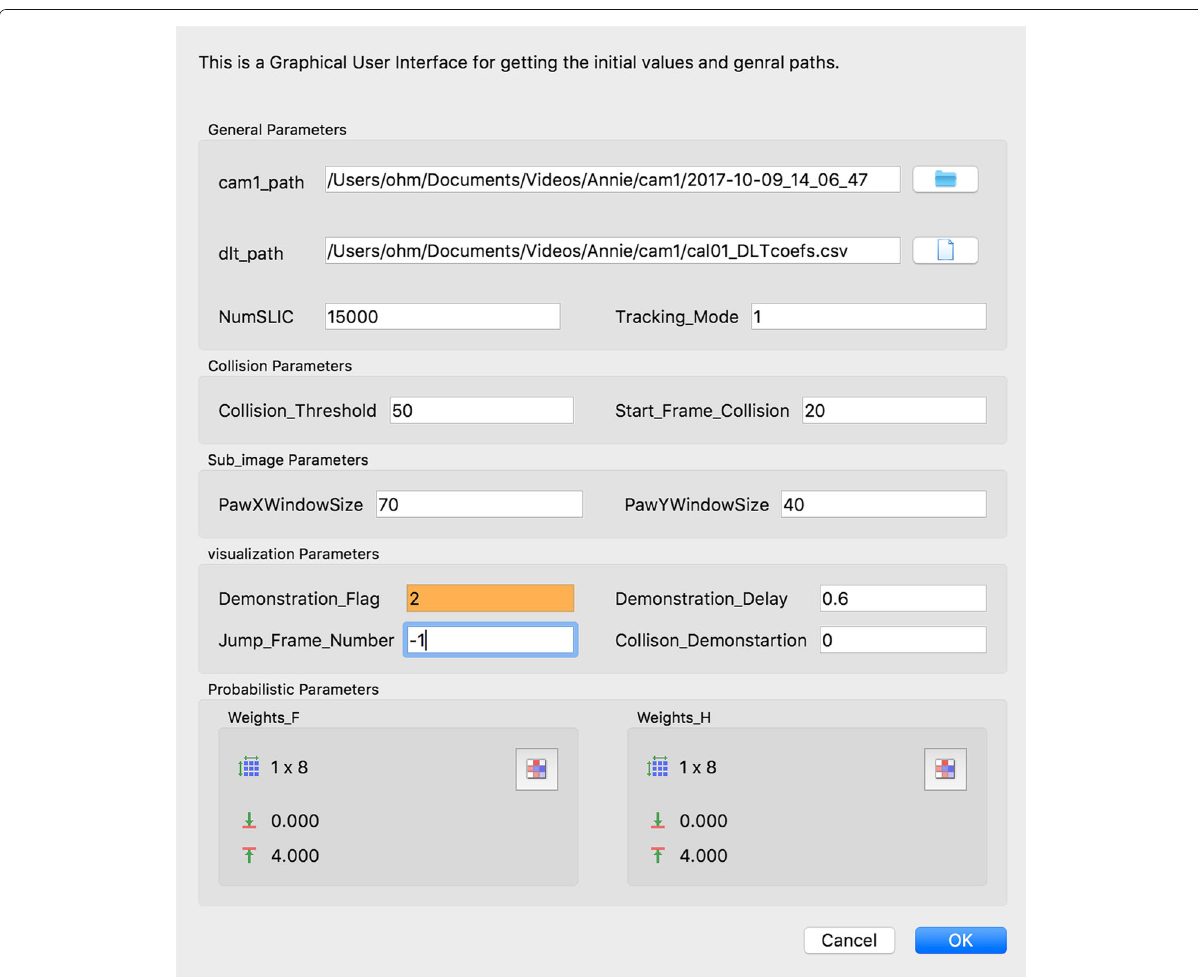
Fig. 6 The Python GUI. Five major parameters classes are illustrated in the GUI: general, collision, “sub-image”, visualization, and fusion parameters. The general parameters contain the camera one path which the other paths would be found based on this by just replacing the camera number. The collision parameters show the two major parameters to resolve the collision issue. The “sub-image” parameters easily help the user to set the paw region that segmentation would be done. The visualization parameters can be adjusted based on the user need. The fusion parameters are the two weight factors being used in Eq. 5. Therefore, the user can adjust the parameters based on the setup and animal. Last but not least, if a parameter would be set out of the acceptable boundary, like Demonstrating_Flag, the system will highlight